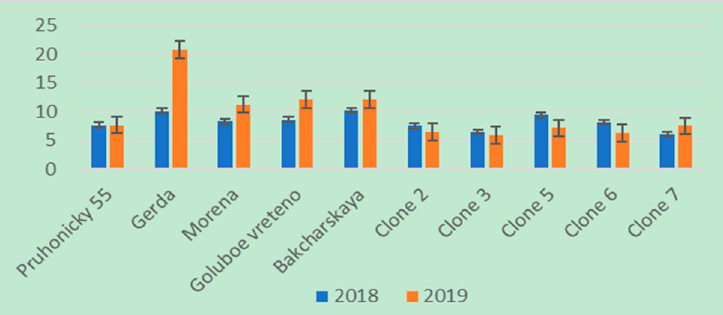
Figure 2. Antioxidant activity (TAA) (equivalent to TROLOX mg L − 1 ) in fruits of edible honeysuckle cultivars and clones in the years 2018–2019.